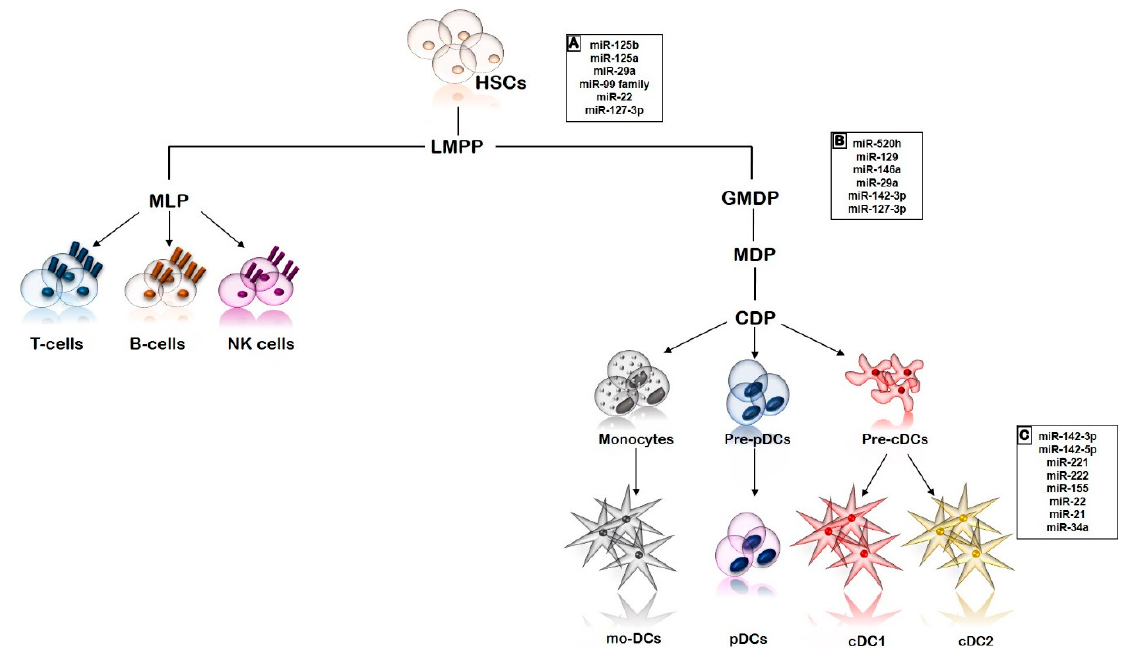
Figure 1. Schematic representation of the main phases of dendritic cell development and di ff erentiation. For each step, miRNAs are involved in ( A ) maintenance and ( B ) di ff erentiation of HSCs and ( C ) in the development and di ff erentiation of DC subsets are reported. Abbreviations: hematopoietic stem cells (HSCs), lymphoid primed multipotent progenitor (LMPP), multipotent lymphoid progenitors (MLP), natural killer cells (NK cells), granulocyte macrophage DC progenitor (GMDP), macrophage DC progenitors (MDPs), common DC progenitors (CDPs), precursors of plasmacytoid DCs (pre-pDCs), precursors of conventional DCs (pre-cDCs), plasmacytoid DCs (pDCs), conventional DCs (cDC), and monocytes-derived DCs